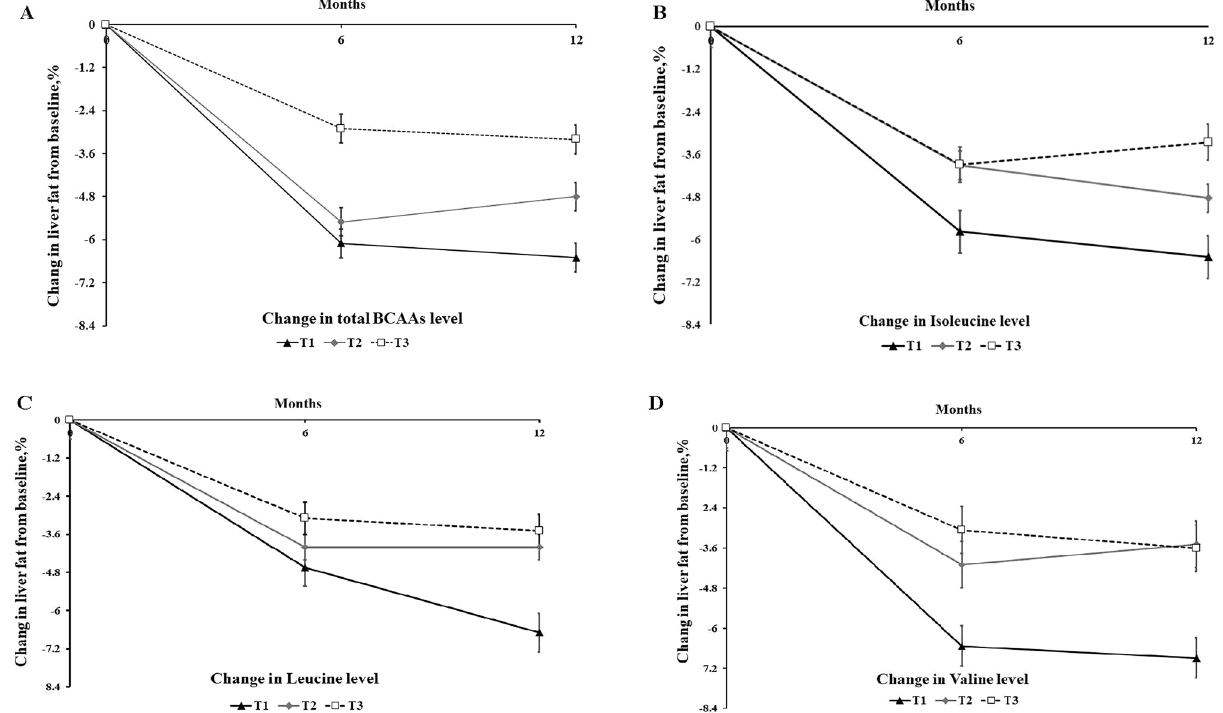
Figure 1. Trajectories of changes in liver fat content according to initial changes in total BCAAs (panels A ), Isoleucine (panels B ), Leucine (panels C ), and Valine (panels D ). Data were adjusted for age, sex, total energy intake, protein intake, intervention group, HOMA-IR, BMI, liver fat content at the baseline, value for the each metabolites (total BCAAs, Isoleucine, Leucine, Valine) at the baseline, and changes in HOMA-IR and BMI form baseline to 6 months. The lowest tertile (T1) category indicates the largest reduction of circulating metabolites from the baseline to 6 months. Metabolite categories are defined as follow: total BCAAs level-T1, ≤ − 2.8 μg/ mL; T2, − 2.8 to 4.7 μg/mL; T3, ≥ 4.7 μg/mL; Isoleucine level-T1, ≤ − 0.55 μg/mL; T2, − 0.55 to 0.88 μg/ mL; T3, ≥ 0.88 μg/mL; Leucine level-T1, ≤ − 0.73 μg/mL; T2, − 0.73 to 1.86 μg/mL; T3, ≥ 1.86 μg/mL; Valine level-T1, ≤ − 1.77 μg/mL; T2, − 1.77 to 2.41 μg/mL; T3, ≥ 2.41